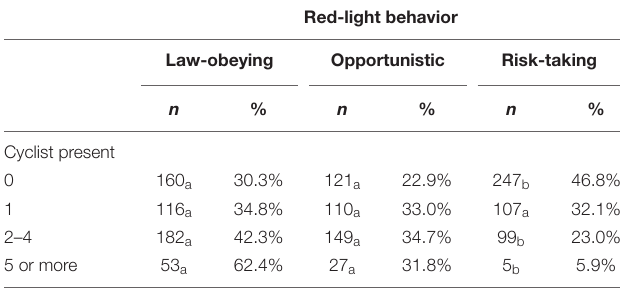
TABLE 3 | Red-light behavior frequencies by the presence of